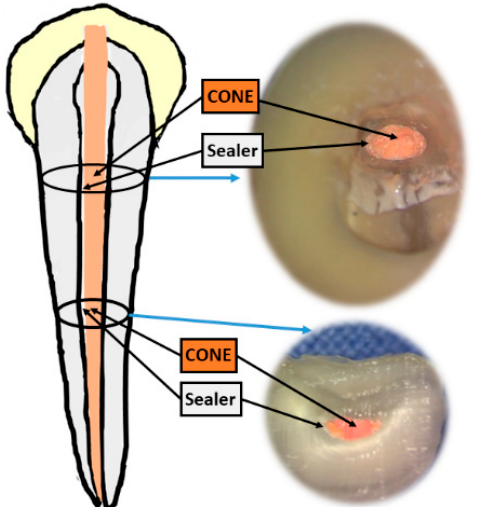
Figure 1. The illustration of filling materials for root canal therapy.